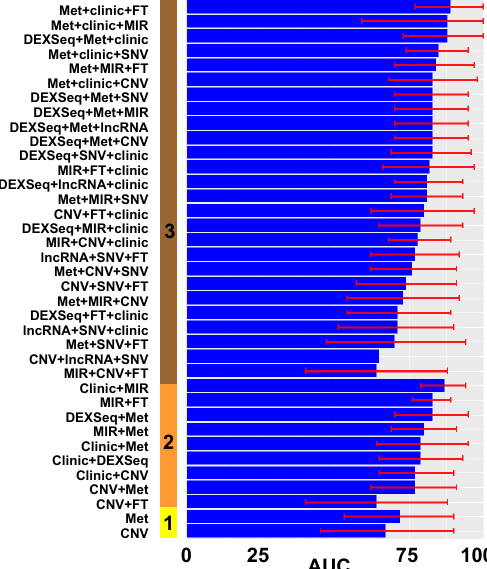
(Met) data and 16 of 37 (43%) contained clinical data.